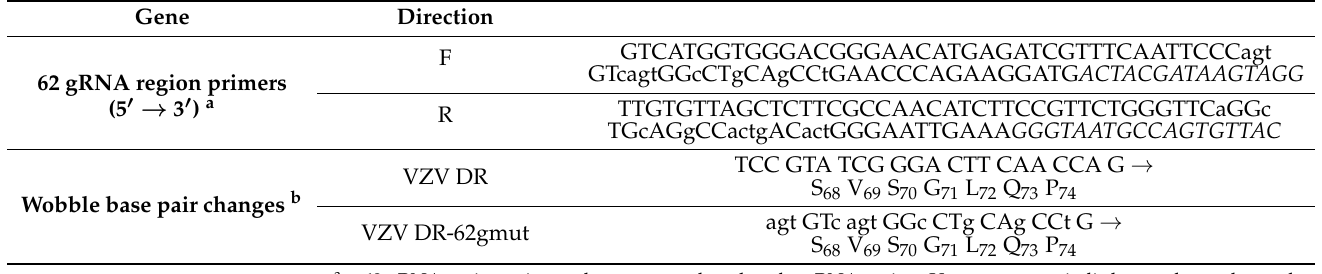
Table 3. Primer Design for VZV DR-62gmut BAC